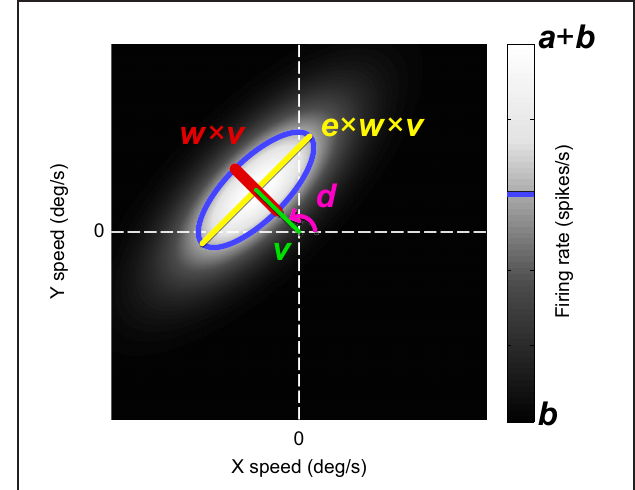
FIGURE 3 | The six-parameter model used to fit the neural responses (grayscale) to the horizontal (X) and vertical (Y) stimulus speeds. The model was a 2D Gaussian in velocity space with its center at the polar coordinates d (the preferred direction) and v (the preferred speed). The width of the Gaussian in the preferred direction, w , was expressed as a Weber fraction of v . The Gaussian width in the orthogonal direction was defined as the product of e , w, and v . Larger e means more constraint line tuning. Parameter b was an offset representing the baseline firing rate and a was the amplitude of the Gaussian. The blue contour line indicates one standard deviation from the Gaussian